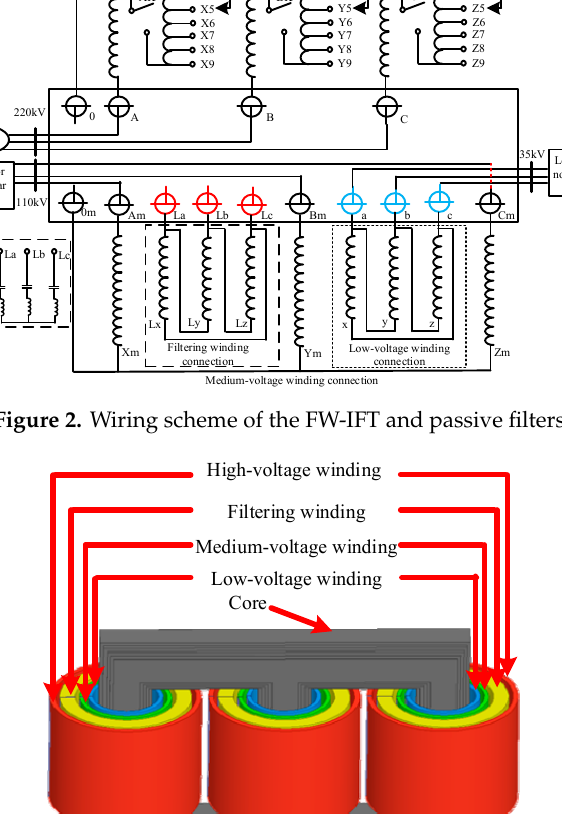
Figure 3. Three-dimensional finite element model of the FW-IFT.